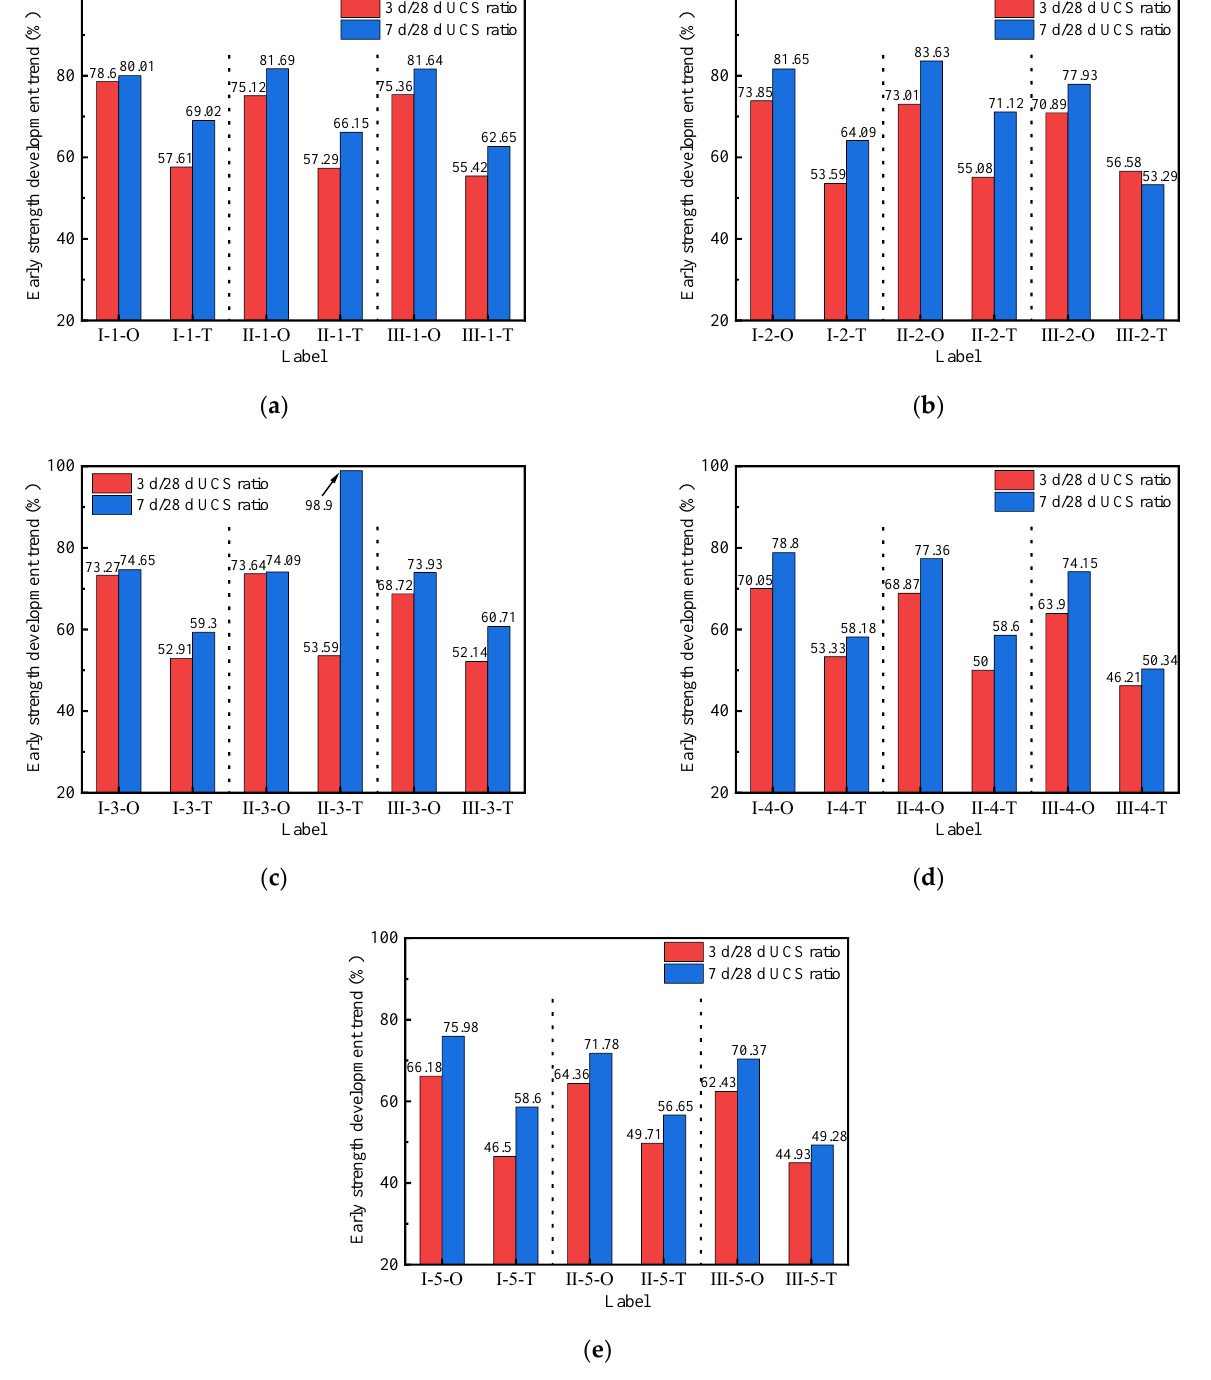
Figure 4. UCS value of stabilized soil with different alkali activator modulus: ( a ) 0.9; ( b ) 1.2; ( c ) 1.5; ( d ) 1.8; ( e ) 2.1.